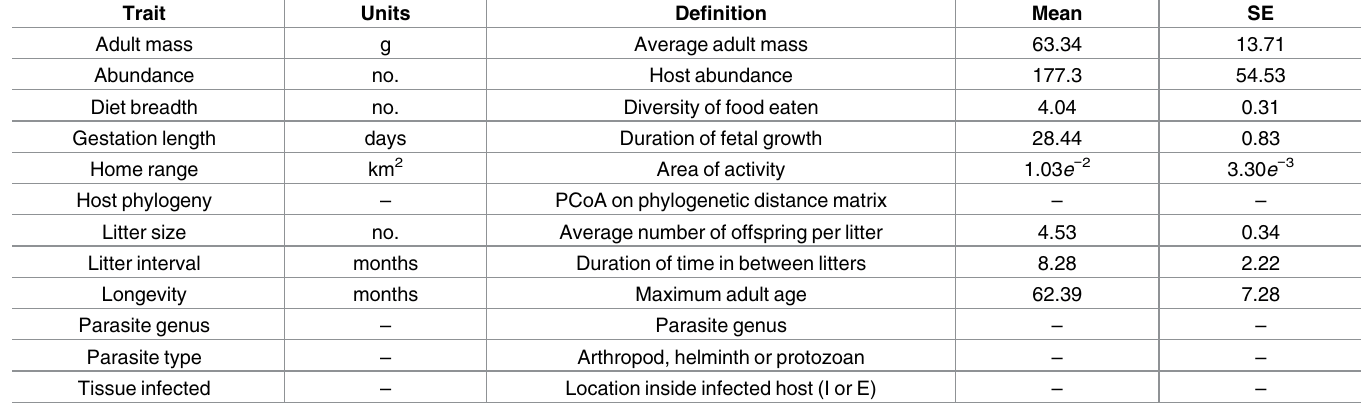
Table 1. Description and units of variables used to predict host-parasite network